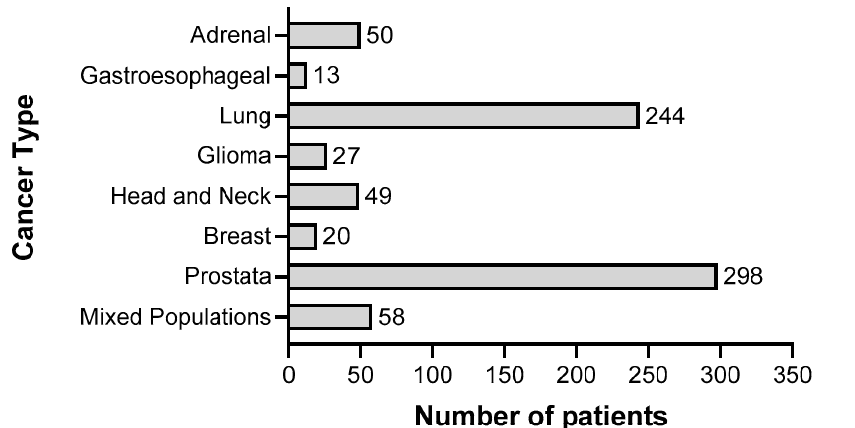
Figure 3. Representation of the total number of patients (n = 759) in relation to cancer type, who were treated with gossypol/AT-101 within clinical trials summarized in this systematic review.